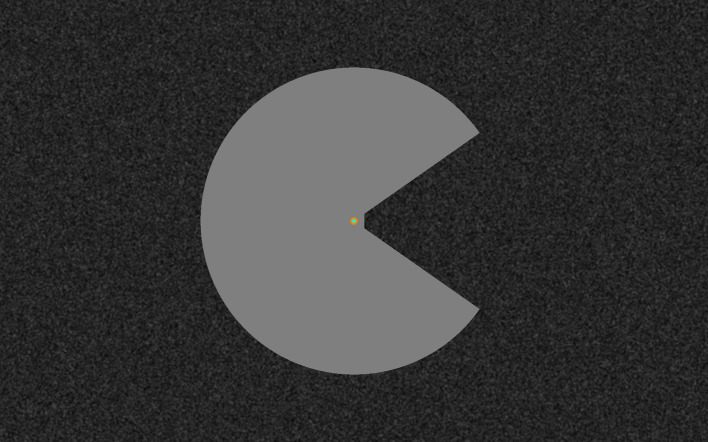
High-resolution image of the ‘Pac-Man’ stimulus and the texture background.When this figure is rendered such that the radius of the disk is 3.75 cm, and viewed from a distance of approximately 57 cm, it gives an impression of what the stimuli looked like to the participants in the scanner. Videos of the stimuli are available online (https://doi.org/10.5281/zenodo.2583017).